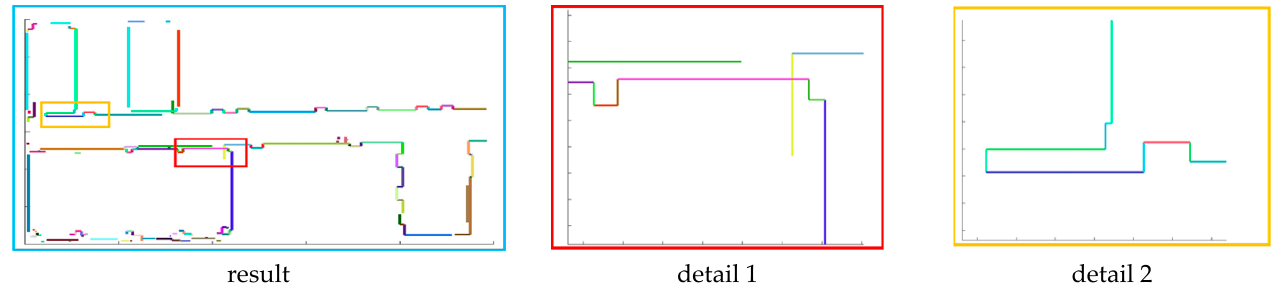
Figure 18. The result of line correction. All the lines that satisfy the condition are connected and we show them in detail.